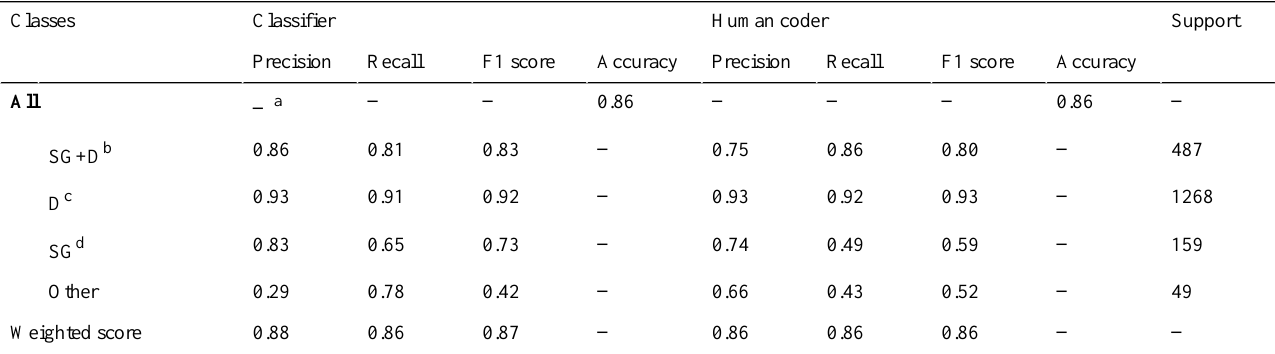
Table 4. Performance of the classifier in a fully inclusive layout.